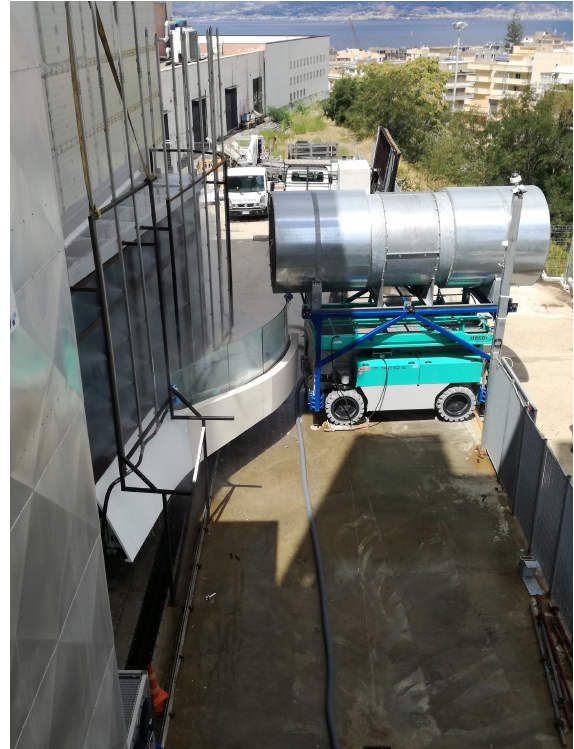
Figure 4. Hurricane test on mock-up